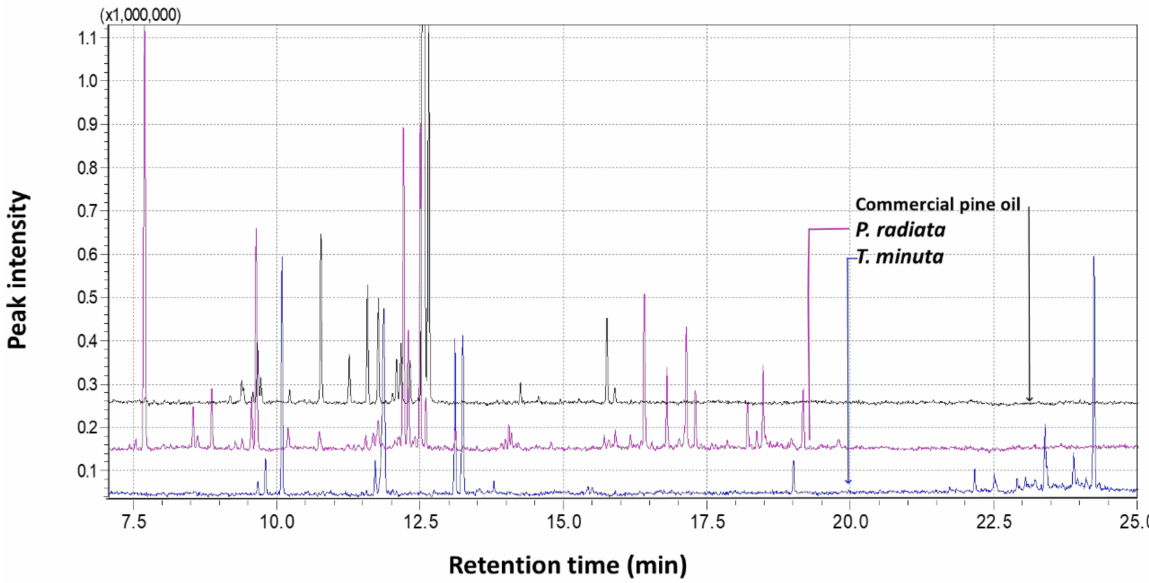
Figure 7. Representative chromatograms of the GC-MS analysis of the volatiles from T. minuta (wild marigold) and P. radiata (pine tree) in comparison to the commercial pine oil that was used for BID-SDME method development and